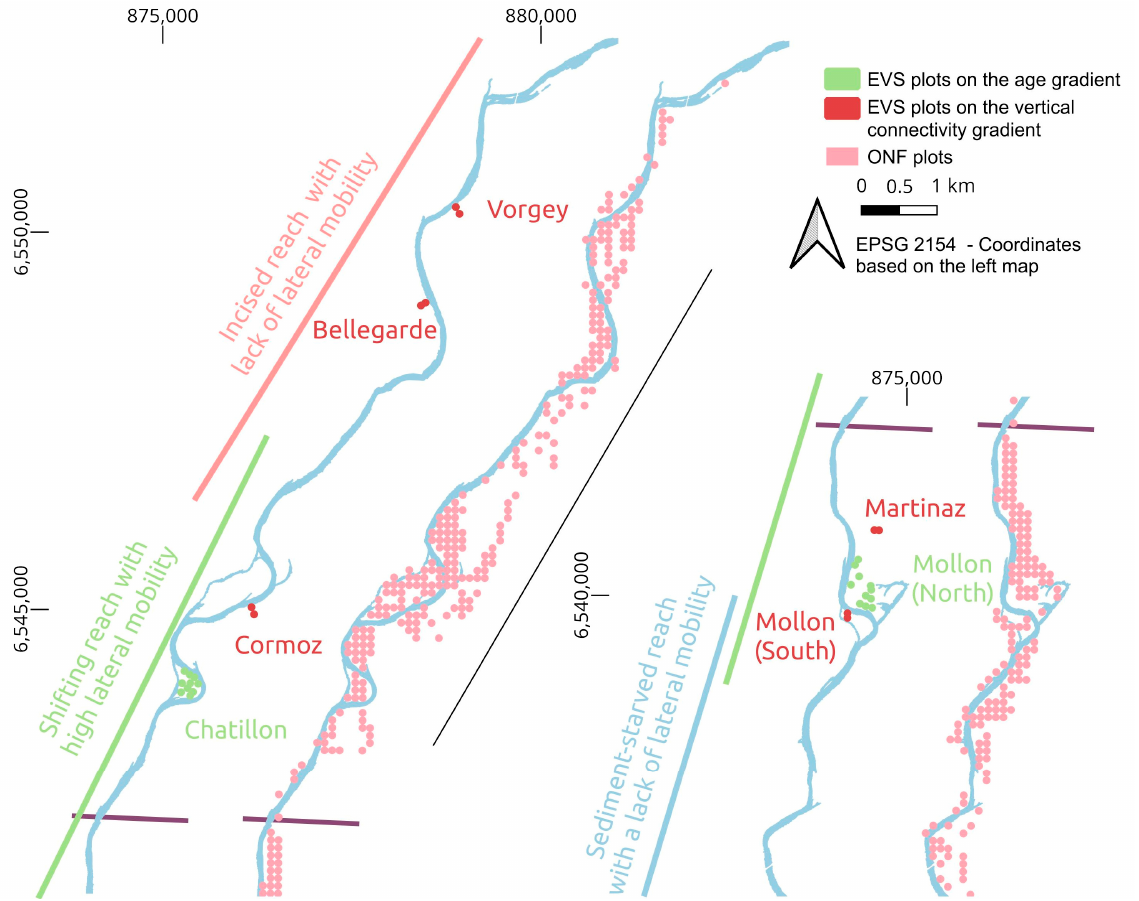
Figure 3. Location of the vegetation plots along the study site. Table 3. Measurements and observations recorded in the two forestry